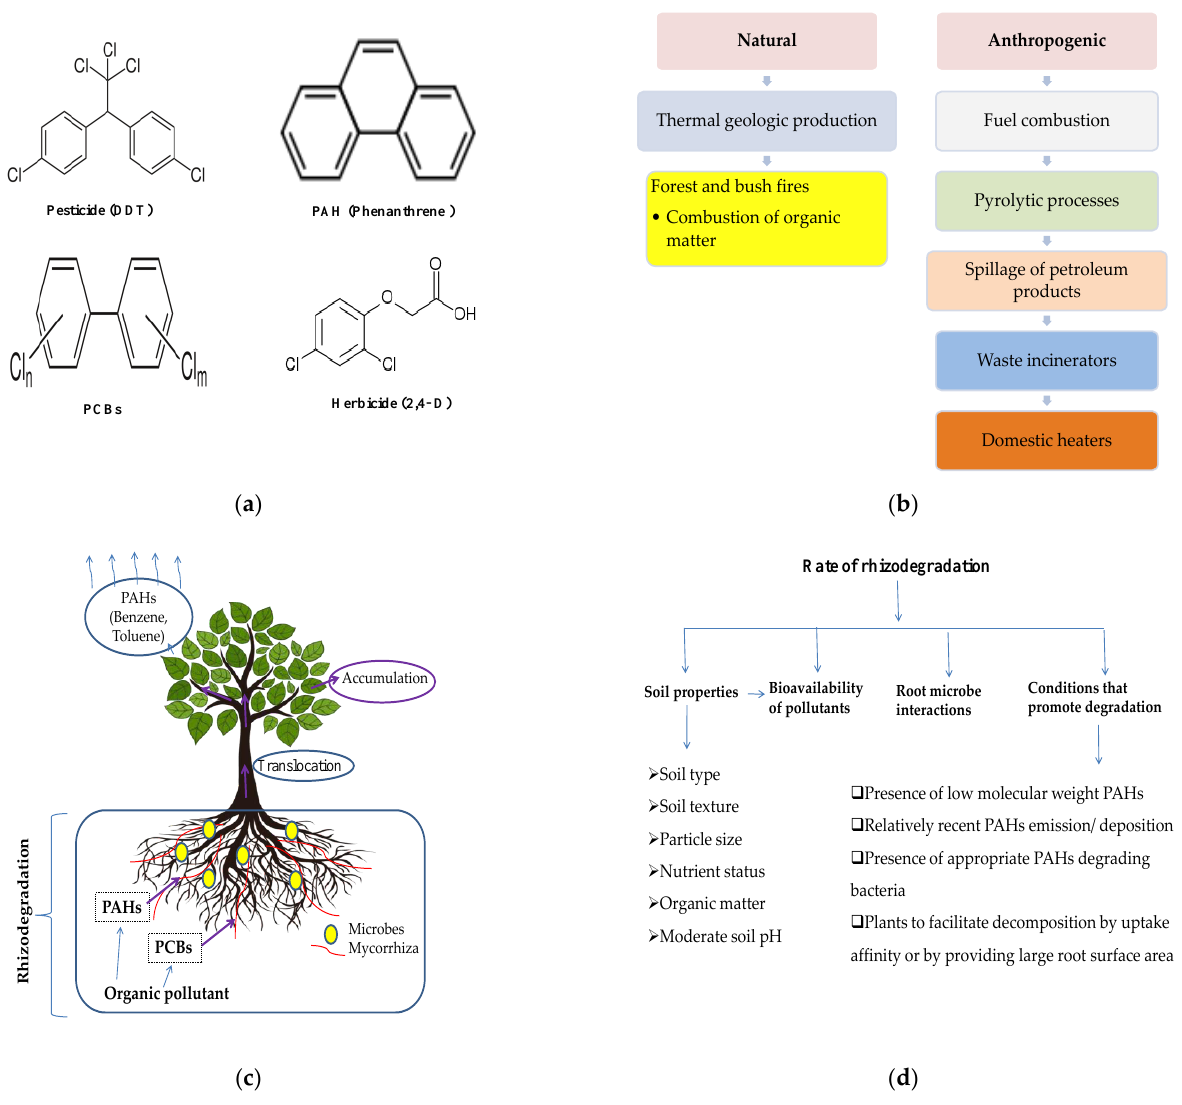
Figure 3. Rhizodegradation techniques: ( a ) chemical structures of different organic contaminants, ( b ) sources of PAH contamination, ( c ) mechanisms of rhizoremediation, and ( d ) factors affecting the rate of rhizodegradation. Table 4. Important enzymes associated with the process of rhizodegradation.